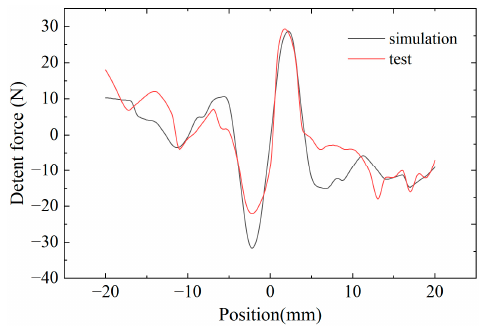
Figure 9. Detent force diagram of the prototype.